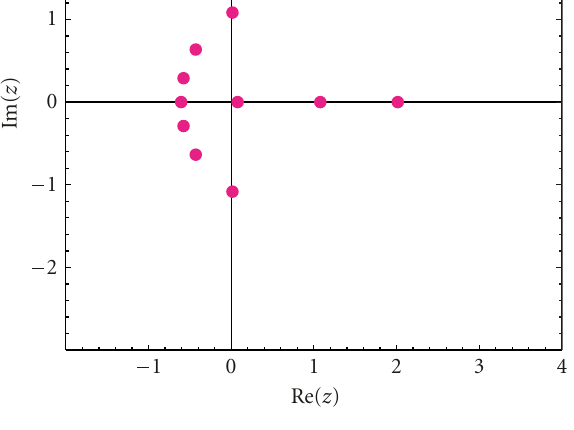
Figure 4.1 . Zeros of E 10, q , w ( x ).